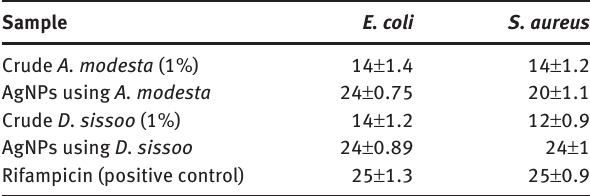
Table 2: Antibacterial activity of gum-based AgNPs. Sample